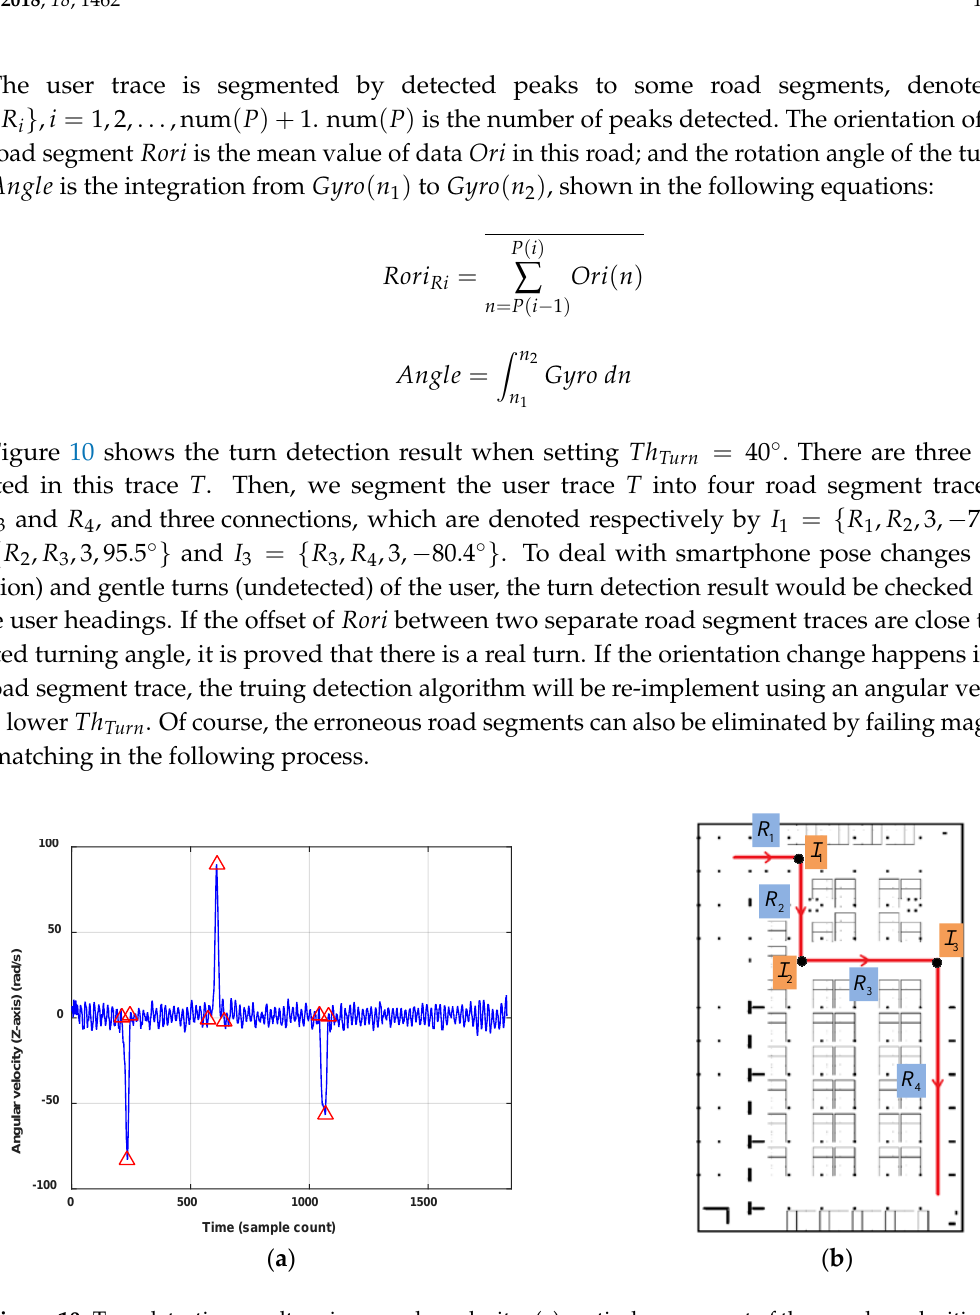
Figure 10. Turn detection results using angular velocity: ( a ) vertical component of the angular velocities (smoothed) of the test trace and the detected start point, peak and end point of each turn; ( b ) four segmented road traces and the three connections between them.